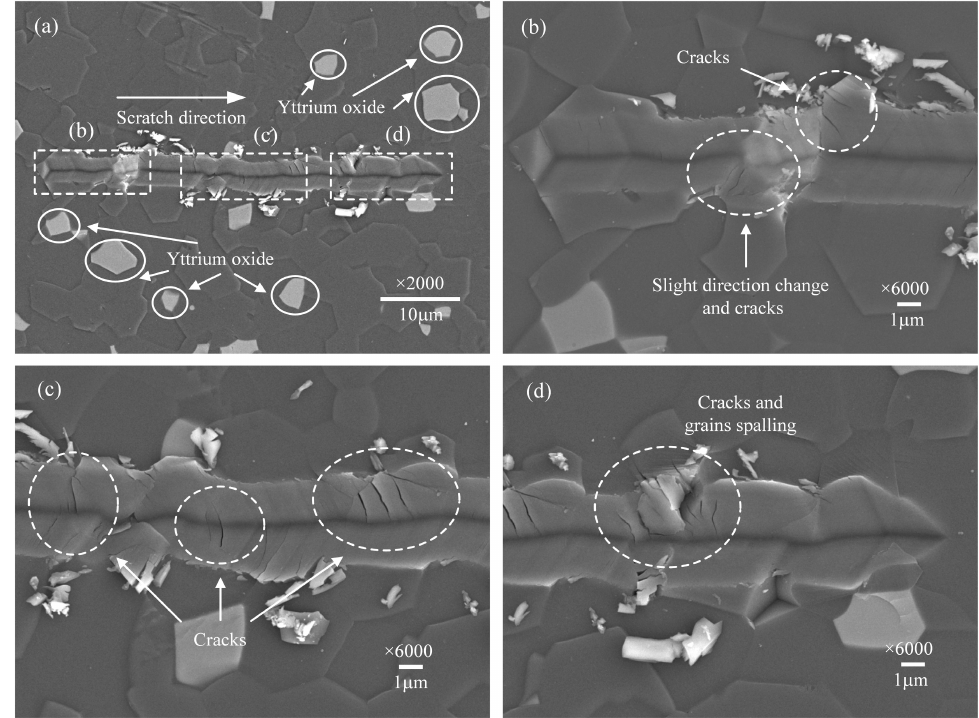
Figure 5. Surface morphology of the scratch groove at the scratch speed of 10 μ m/s. ( a ) is the overall morphology. ( b – d ) are detailed enlarged views.